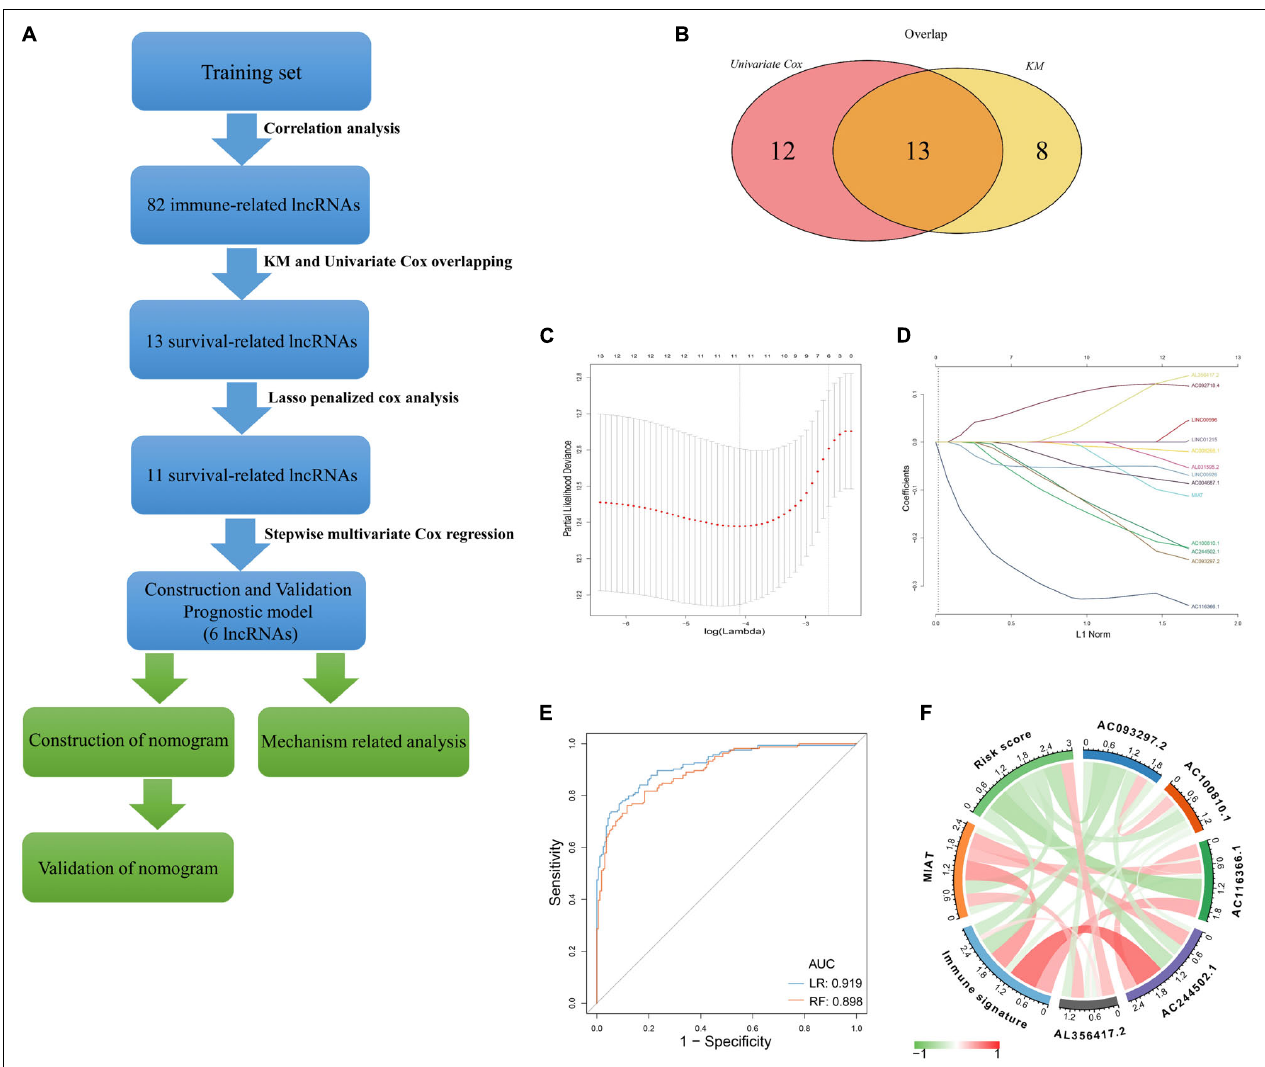
FIGURE 1 | Construction of Immune–related LncRNAs Prognostic Signature (A) Flow chart indicating the analysis procedure. (B) Survival analysis was separately performed by univariate Cox regression analysis and Kaplan–Meier method, of which 13 survival-related lncRNAs were overlapped. (C) The selection of the tuning parameter via 10 times cross–validation in the Lasso model. (D) Lasso coefficient profiles of 13 lncRNAs. (E) The predictive efficacy of the six-lncRNA signature in classification of immune signature. RF: random forest; LR: logistic regression. (F) The correlation identified by Pearson correlation analysis among immune signature, six-lncRNA signature, and six